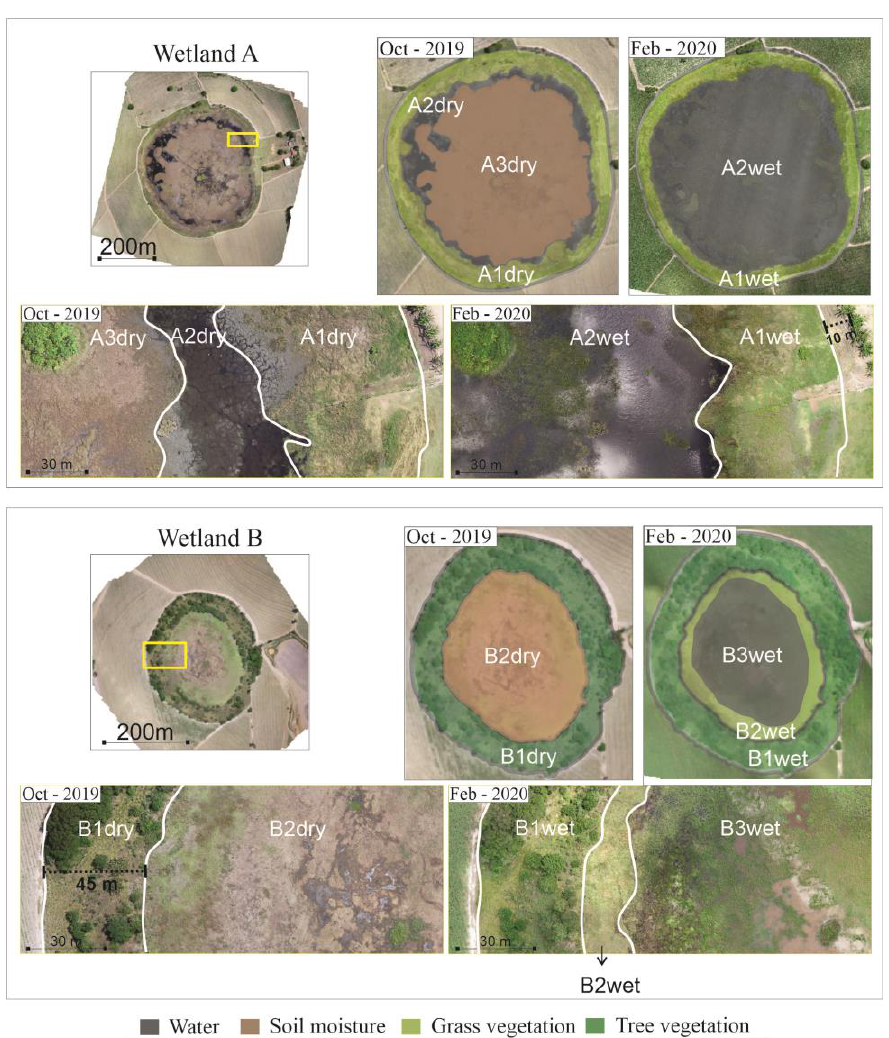
Figure 6. ( A ) The polygons extracted from Wetland A delimit the spatial pattern that reflects the wetland’s characteristics with different RGB pixel responses related to seasonal hydro-periods. The images show a zoom-in view of a border portion of Wetland A for October 2019 and February 2020; ( B ) The polygons extracted from Wetland B delimit the spatial pattern that reflects the wetland’s characteristics with different RGB pixel responses related to seasonal hydro-periods. The images show a zoom-in view of a border portion of Wetland B for October 2019 and February 2020.